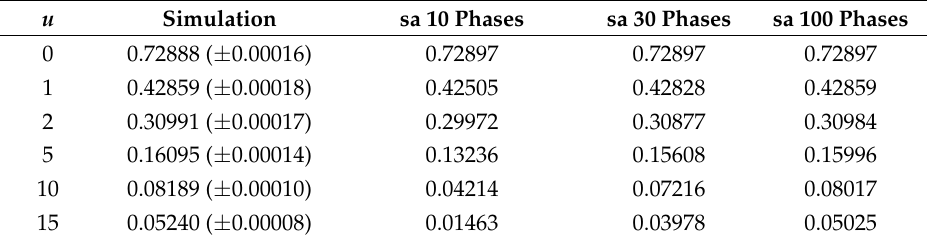
Table 1. The spectral approximation for different number of phases, under Pareto ( 2,3 ) claim sizes. The numbers in the brackets correspond to the confidence intervals of the exact ruin probability. Simulation